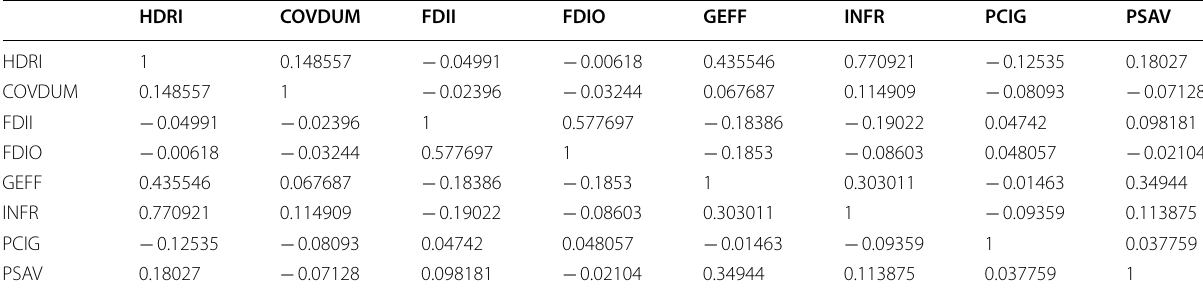
Table 3 Correlation matrix. Source : Computation from World Development Indicator 2022 using